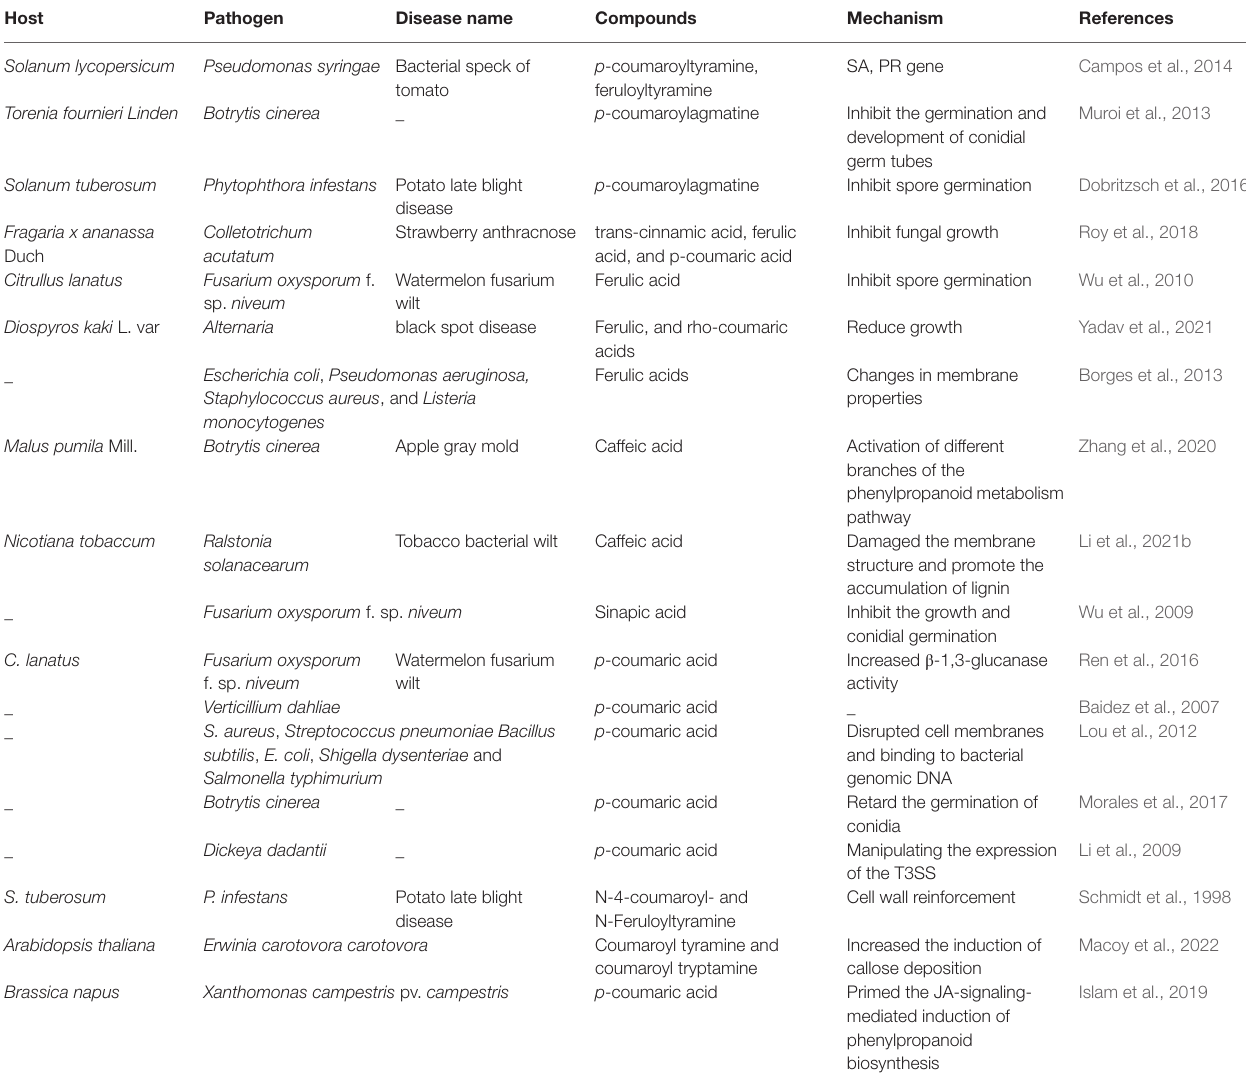
TABLE 1 | Antimicrobial activity of various hydroxycinnamic acids (HCAs)/hydroxycinnamic acid amides (HCAAs) and their